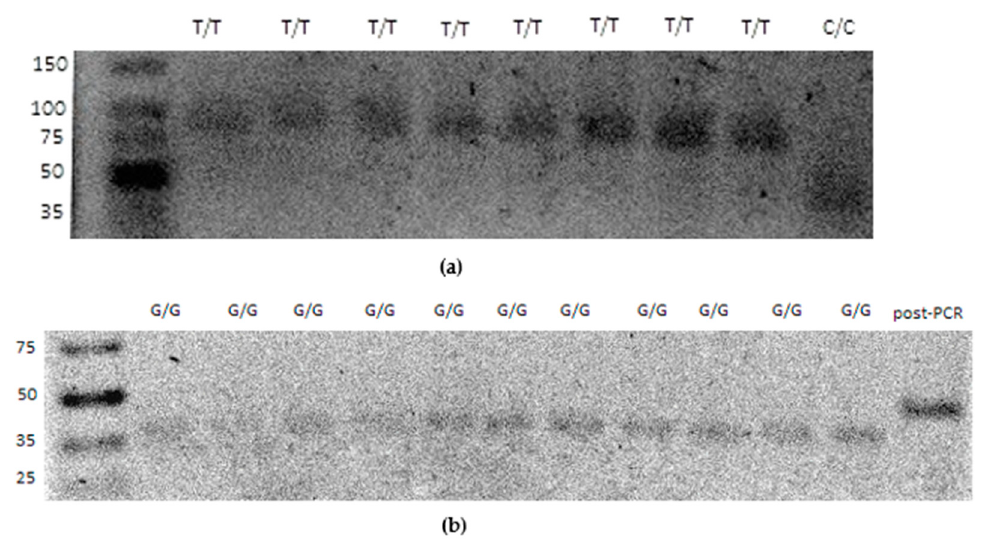
Figure A2. Examples of electropherograms used in the genotyping of: ( SOD2 ) ( a ), rs8192287 ( SOD3 ) ( b ).